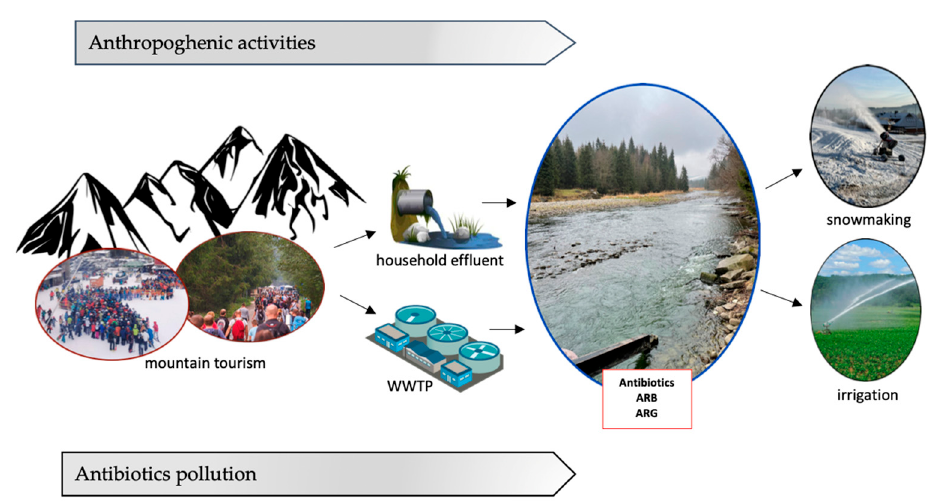
Figure 1. Dissemination routes of antibiotics and drug resistance determinants in the mountain en- vironment.